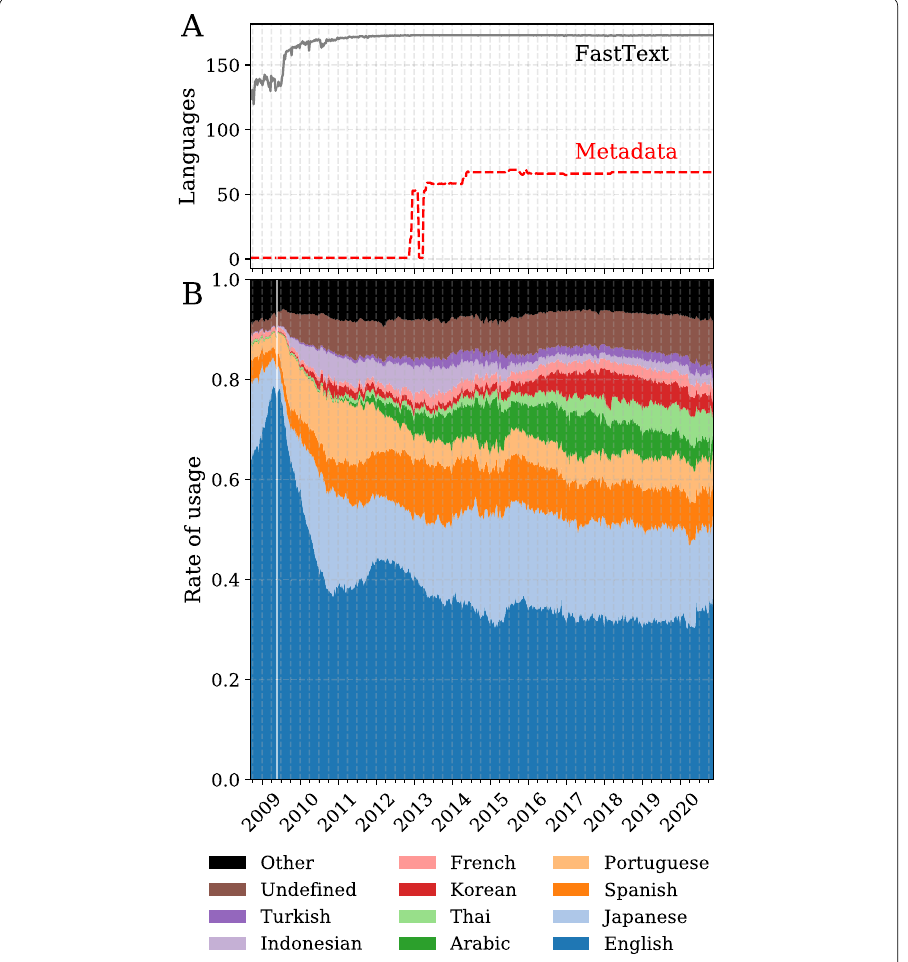
Figure 1 Language time series for the Twitter historical feed and FastText-LID classified tweets. ( A ) Number of languages reported by Twitter-LID (red) and classified by FastText-LID (black) since September 2008. Fluctuations in late 2012 and early 2013 for the Twitter language time series are indicative of inconsistent classifications. ( B ) Rate of usage by language using FastText-LID maintains consistent behavior throughout that period. The change in language distribution when Twitter was relatively immature can be readily seen—for instance, English accounted for an exceedingly high proportion of activity on the platform in